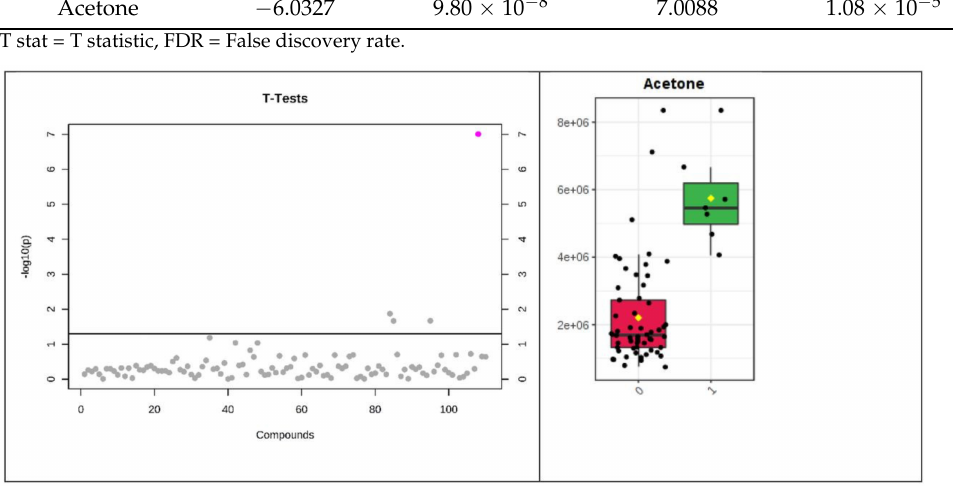
Figure 2. SPME urine NTproBNP > 211 pmol/L. Log10 transformed t -test p -values for individual metabolites with p -value threshold for multiplicity (horizontal line) ( left ). Single VOC reaching statistical significance ( right